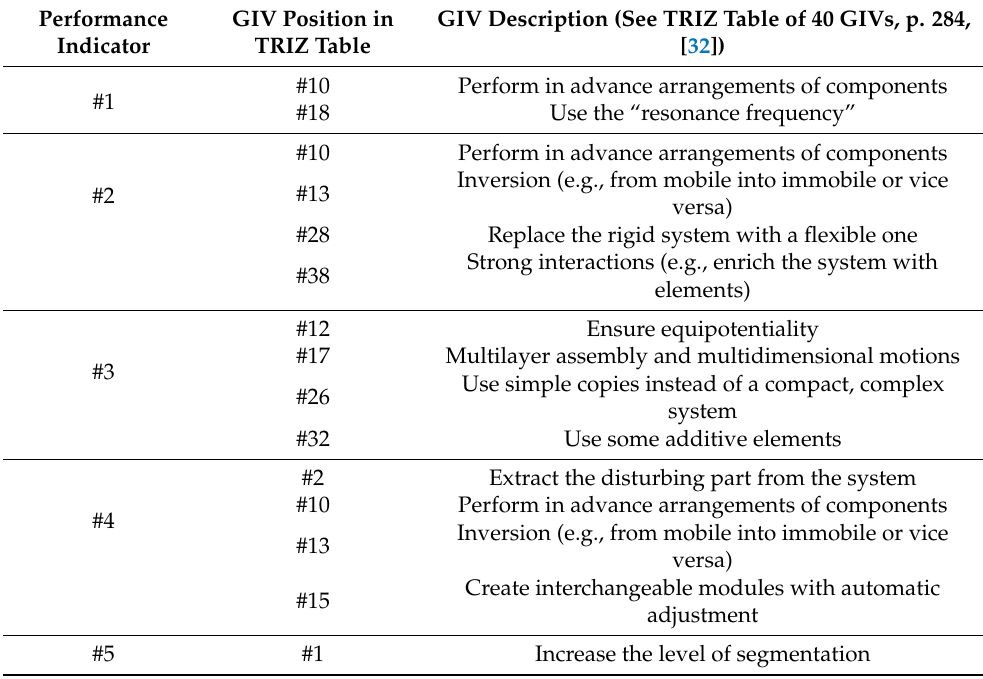
Table 1. GIVs for the case study under